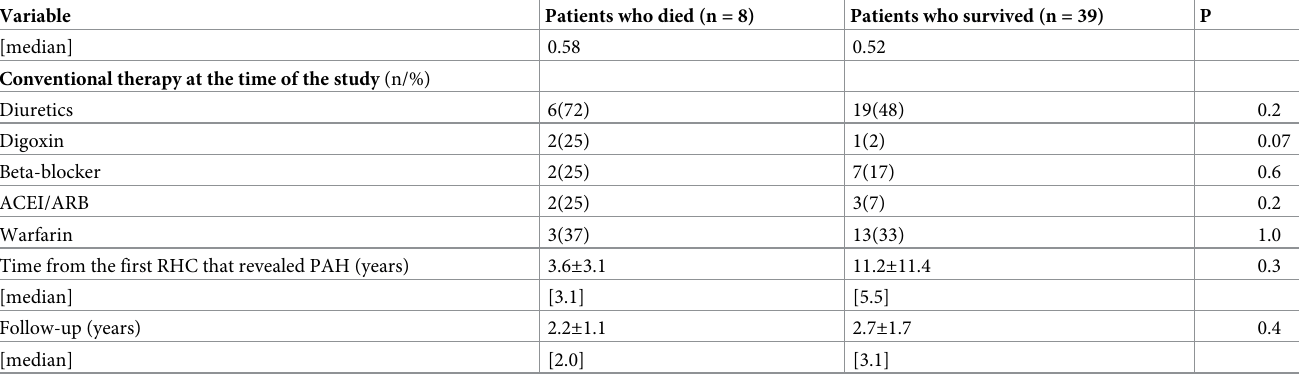
RV strain. In multivariate analysis, independent predictors of mortality included higher BNP and bilirubin levels, higher right atrial area, and lower TAPSE (Table 4).